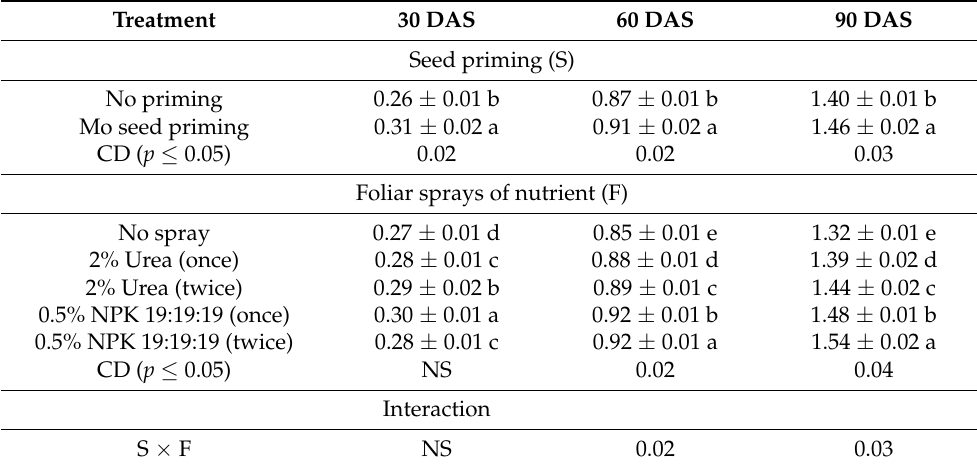
Table 4. LAI of grass pea at different growth stages (pooled means of 2